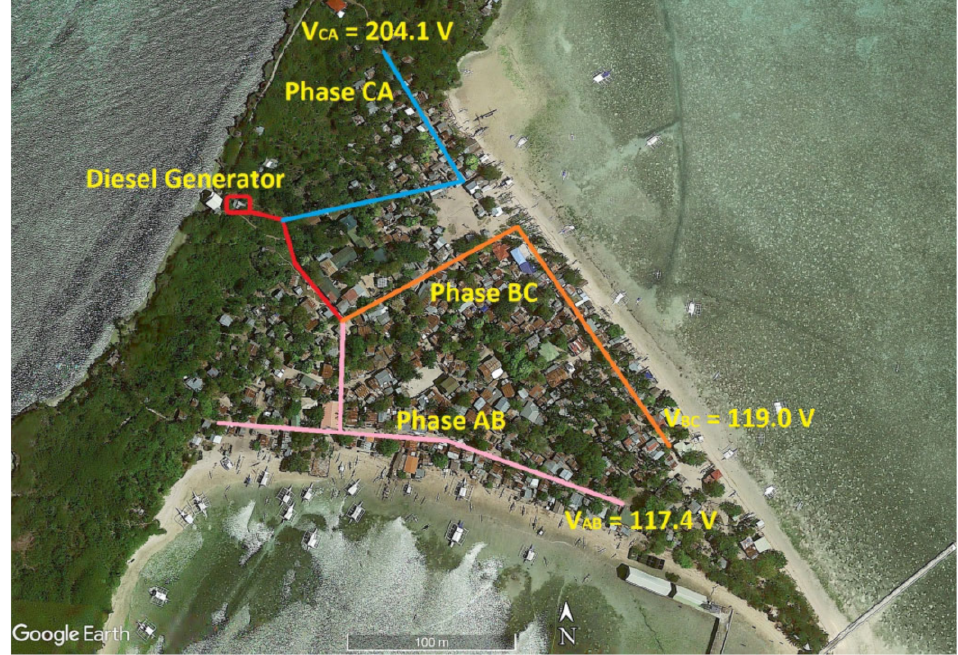
Figure 6. The electrical distribution backbone on Gilutongan Island superimposed on satellite imagery from Google Earth. The voltages near the end-points of each phase are